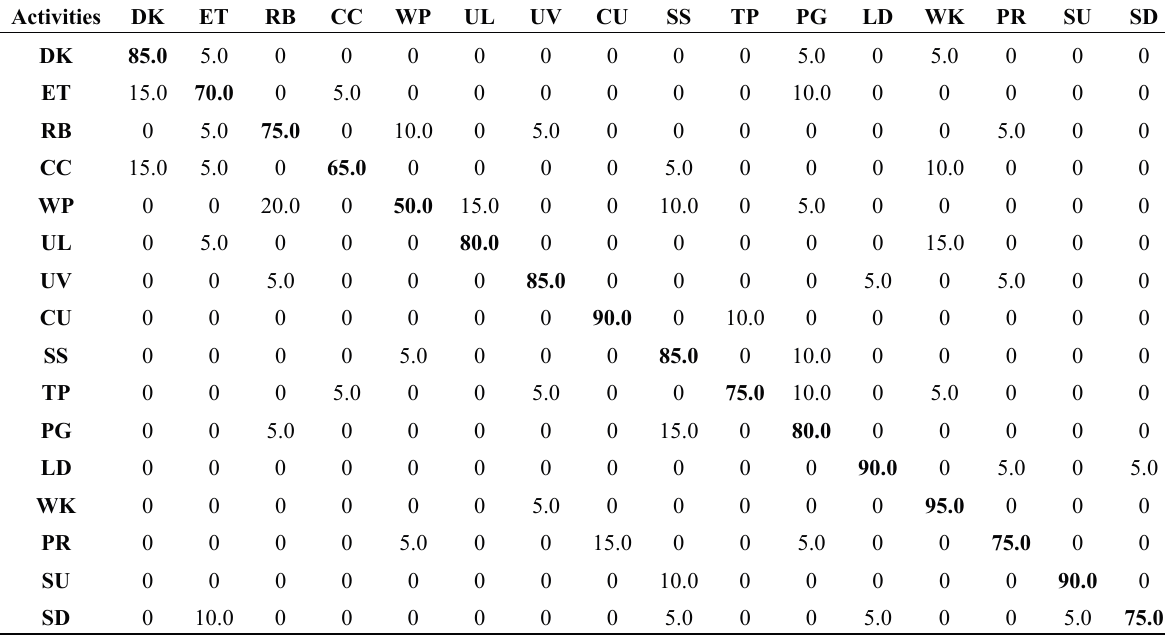
Table 13. Confusion matrix of the proposed method using the MSRDailyActivity3D dataset. To have a clear view, we use two characters to represent each activity. Drink (DK), eat (ET), read book (RB), call on cellphone (CC), write on a paper (WP), use laptop (UL), use vacuum